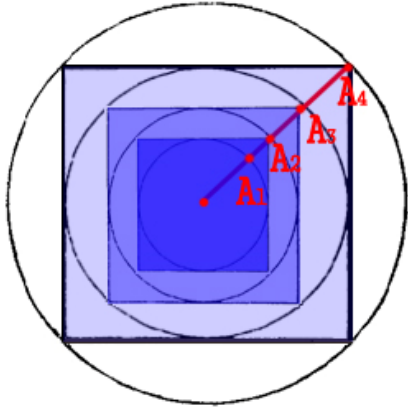
Figure 6. Superimposing the circle–square and the square–circle maps.